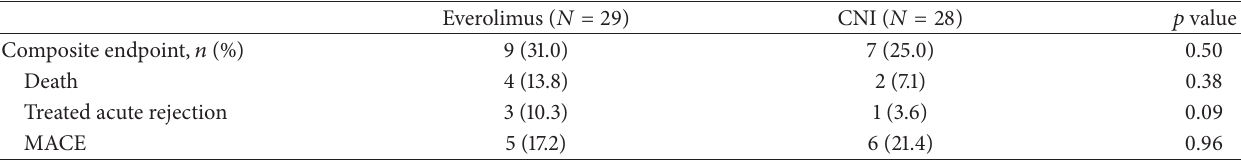
Table 2: Safety endpoints at year 3.